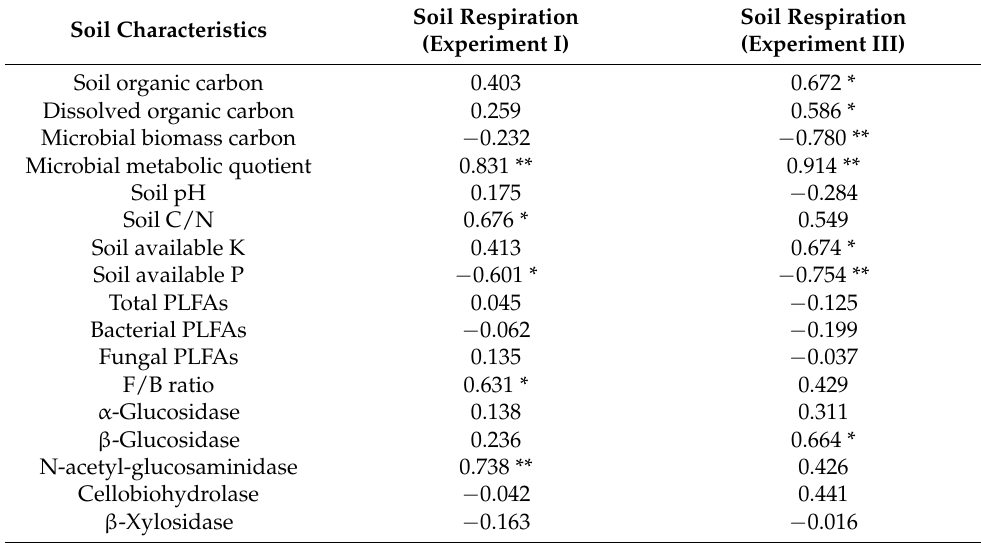
Table 3. Person correlation between soil respiration during the aerobic period and soil characteristics.